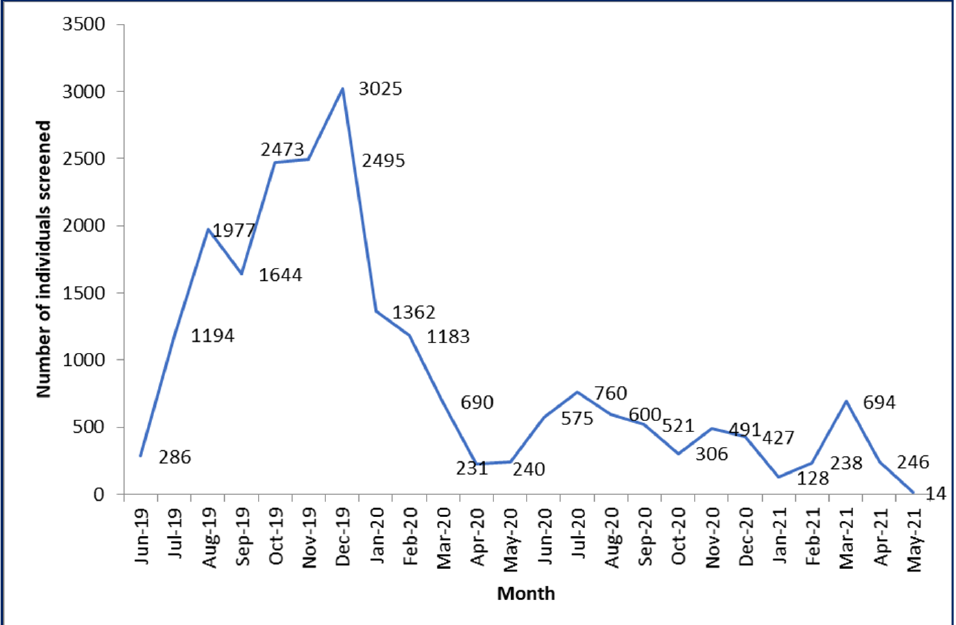
Figure 1. Monthly trend in the aggregate number of individuals screened for NCD risk factors in